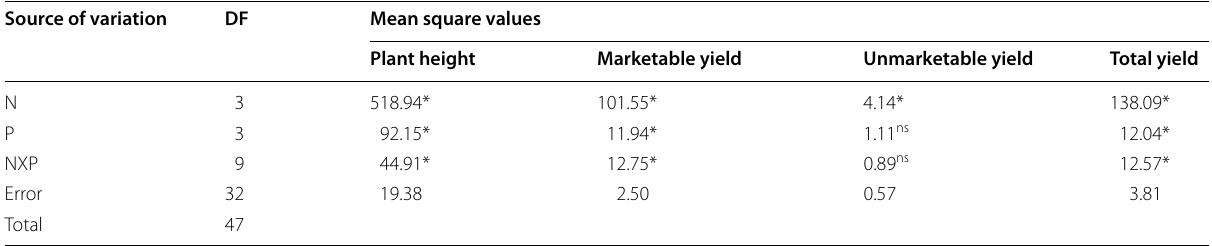
ns non-significant, * and ** significant and highly significant respectively